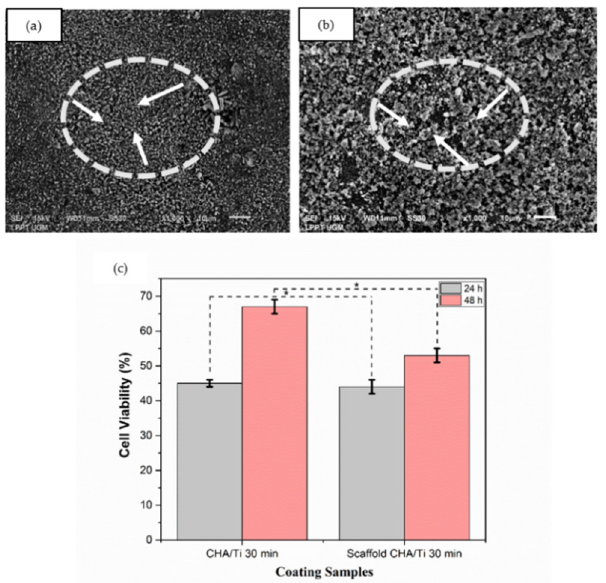
Table 2. Average Cell Viability of CHA/Ti 30 min and CHA/HCB/Ti 30 min.